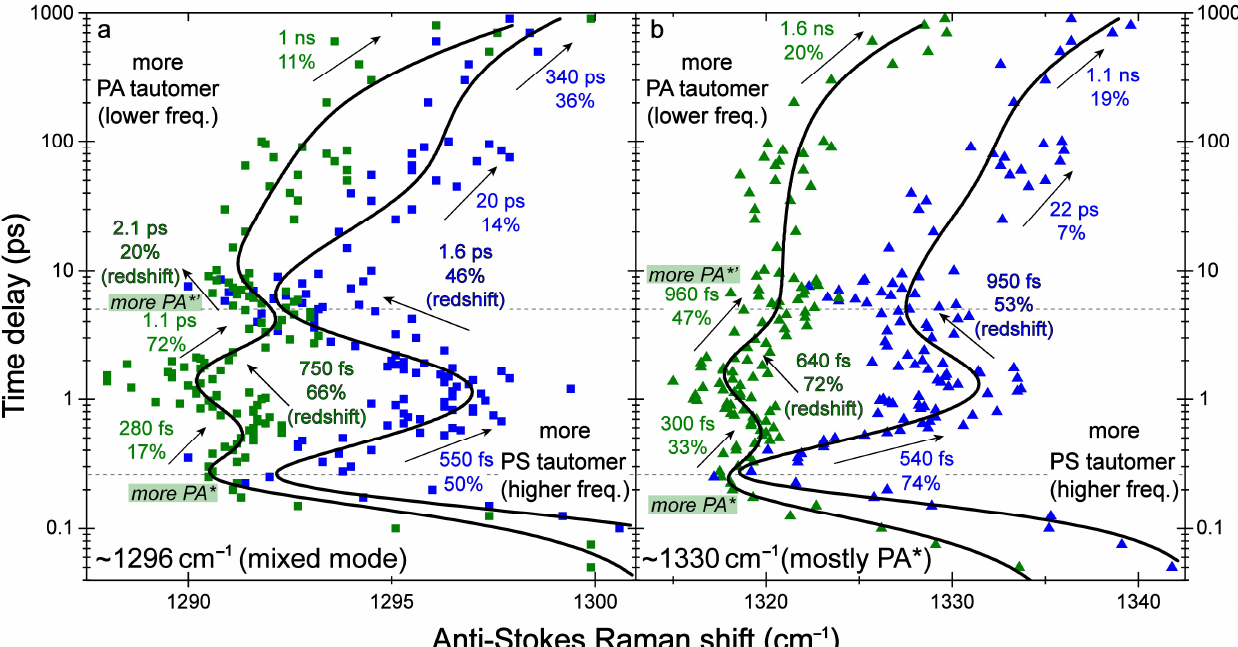
Figure 5. Structural dynamics traces obtained from ES-FSRS of Draconin Red in DCM solvent using a 490 nm actinic pump with a 620 nm Raman pump (blue) and a 537 nm actinic pump with a 645 nm Raman pump (green) for the ( a ) 1296 cm –1 (data points in squares) and ( b ) 1330 cm –1 (data points in triangles) modes. The pronounced 1296 cm –1 mode is comprised of contributions from a mixed tautomer population on the basis of quantum calculations, while the 1330 cm –1 shoulder peak is primarily associated with the PA* tautomer as the asterisk denotes an excited state species. The least-squares fits are shown in black lines to highlight the peak frequency dynamics, especially their similarities and differences between the two excitation-dependent experiments across the detection time window up to ~1 ns. The retrieved blueshift time constants and amplitude weights (summed to 100%) are listed by the best fits, with the peak frequency redshift components denoted separately with their amplitude weights scaled to the summation of all the blueshift components. The major turning points for the excited-state peak frequency dynamics are denoted by two horizontal dashed lines at ~250 fs and 5 ps with labels of more PA* and more PA*’, respectively.